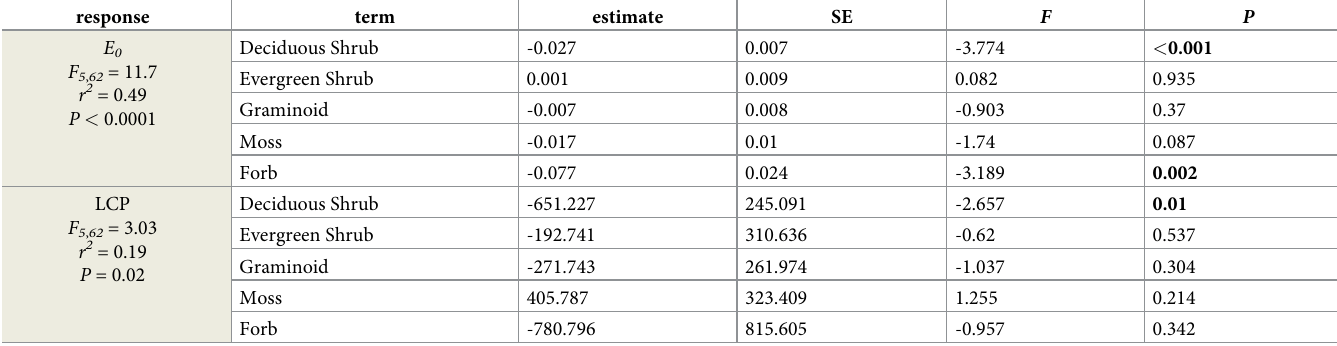
Table 4. Summary of regression models examining the influence of plot top cover (proportion of first pin hits) on plot-level light curve parameters.